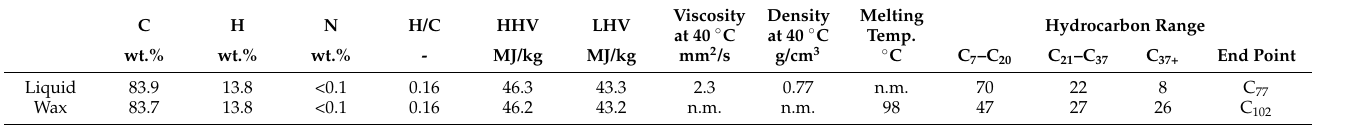
Table 3. Physicochemical properties of the pyrolysis liquid and